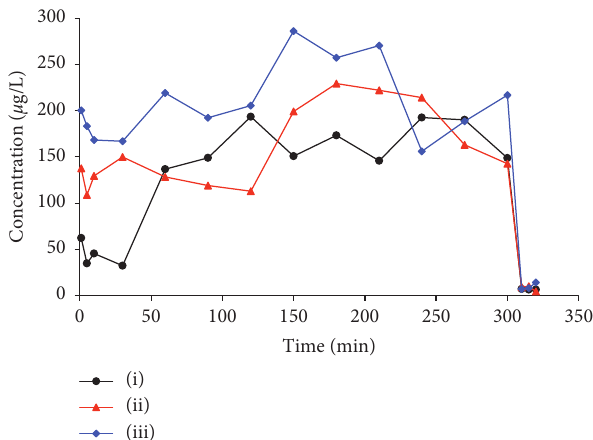
Figure 3: Variations of AgNPs monitored at the sampling points of (i) SP1 at 10 cm, (ii) SP2 at 300cm, and (iii) SP3 at 600cm from the point of entry of the AgNP solution into the water